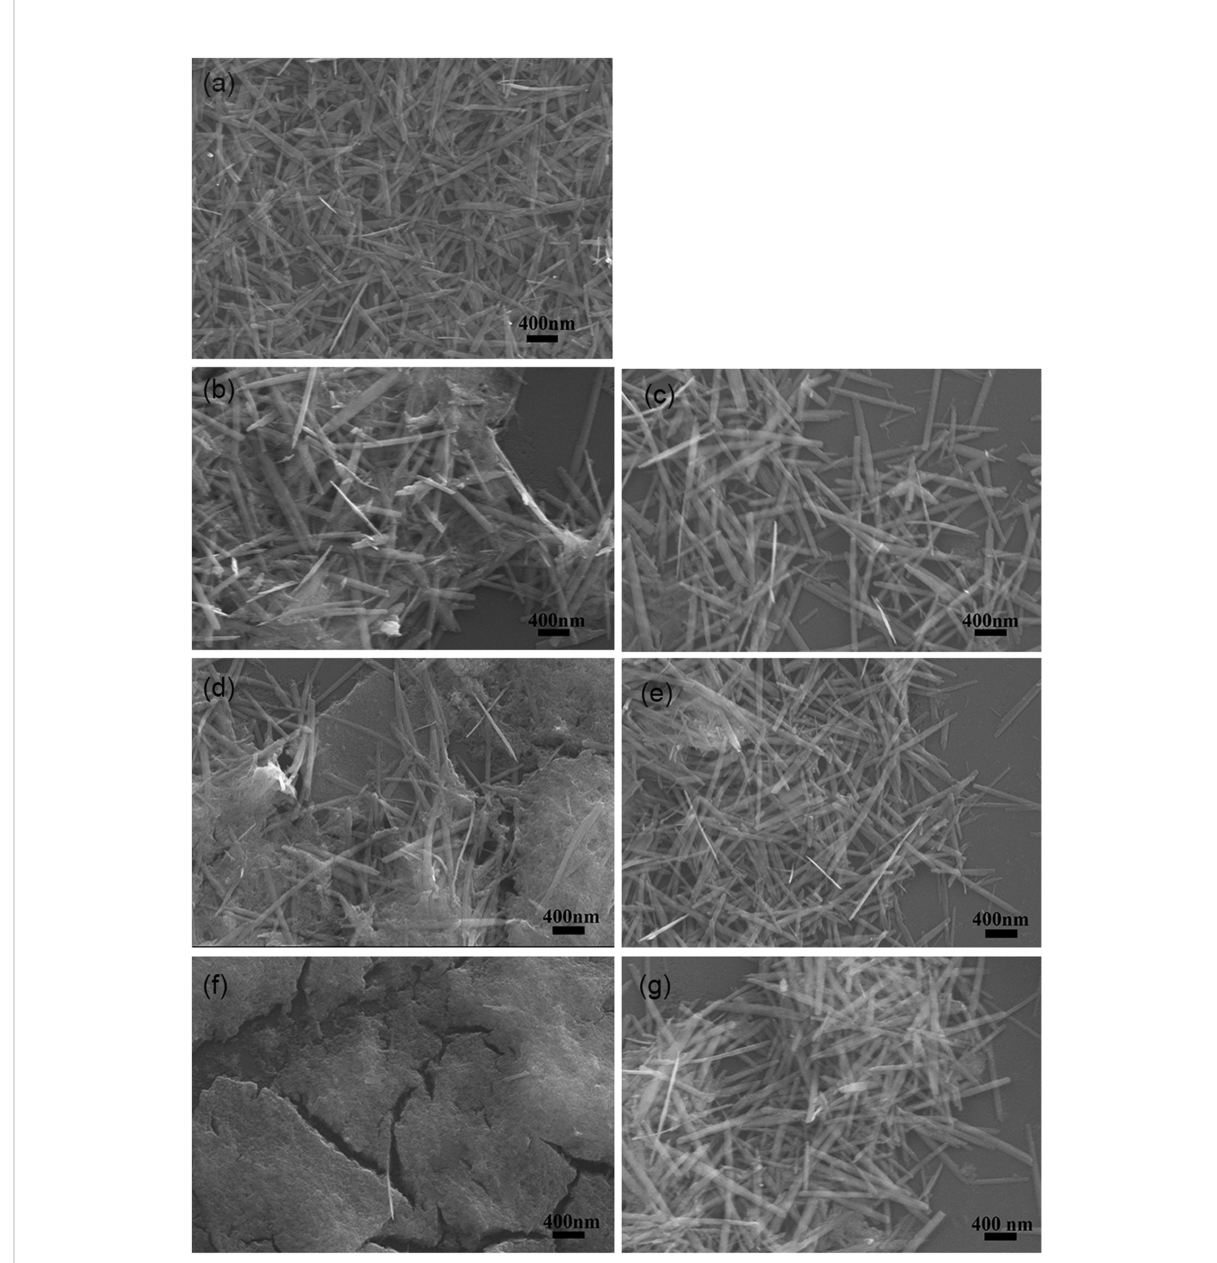
FIGURE 2 SEM images of in vitro goethite crystallization in the presence of CtCBP-1. (A) blank control, (B) 35 µg/ml CtCBP-1, (C) 35 µg/ml MBP, (D) 70µg/ ml CtCBP-1, (E) 70 µg/ml MBP, (F) 140 µg/ml CtCBP-1, (G) 140 µg/ml